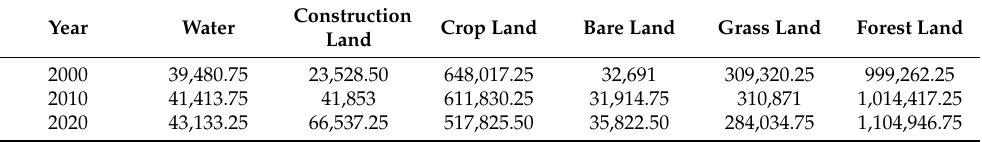
Figure 2. Spatial distribution of the LULC in the YREB from 2000 to 2020. Table 1. The land use patterns change from 2000 to 2020 in the YREB (km 2